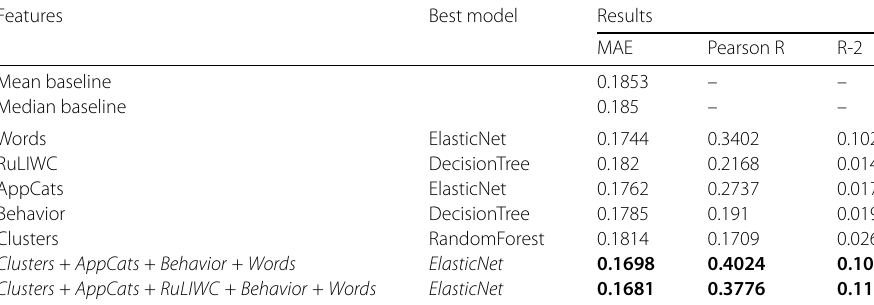
Table 7 SWLS value prediction results